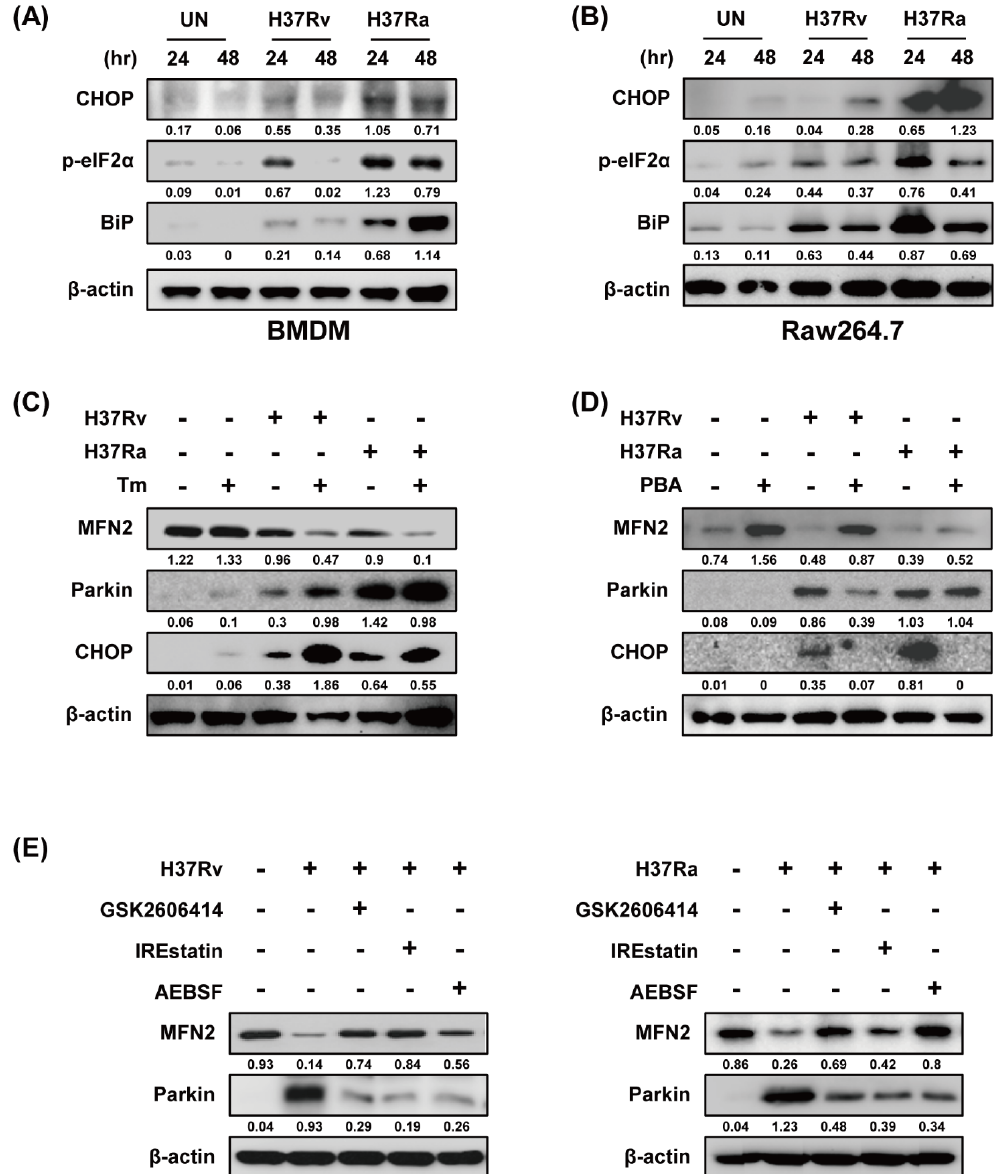
Figure 4. Mtb-induced endoplasmic reticulum (ER) stress modulates MFN2 production in macrophages. ( A and B ) Raw264.7 cells and BMDMs were infected with Mtb at a MOI of 1 for 3 h and CHOP, p-eIF2 α , and BiP were detected by western blotting. β -actin was used as the loading control. BMDMs were pretreated with ( C ) tunicamycin (Tm, 500 ng/mL), ( D ) 4-phenylbutyric acid (4-PBA, 10 mM), or ( E ) ER stress inhibitors (10 μ M GSK2606414, 5 μ M IREstatin, 500 μ M AEBSF) for 1 h and infected with Mtb for 3 h. At 48 h after Mtb infection, western blotting for Parkin, MFN2, CHOP, and β -actin was performed. Data are representative of three independent experiments.